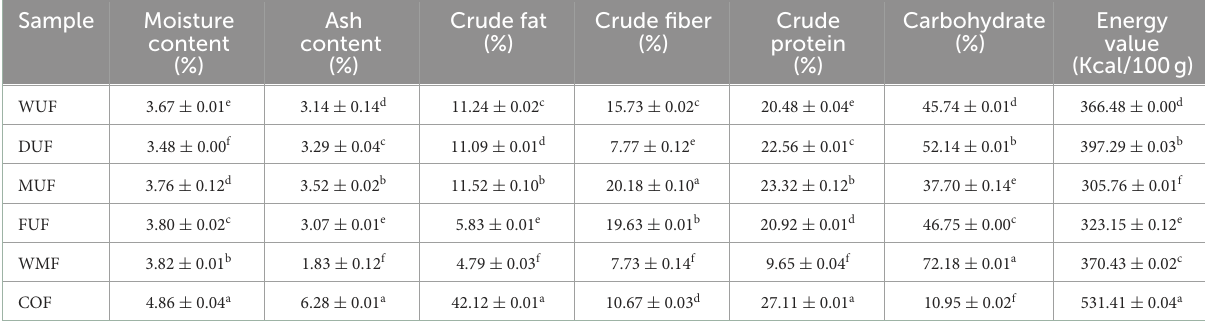
TABLE 2 Proximate composition and energy values of the whole, dehulled, malted, and defatted Ukwa flours, maize flour, and coconut grits.